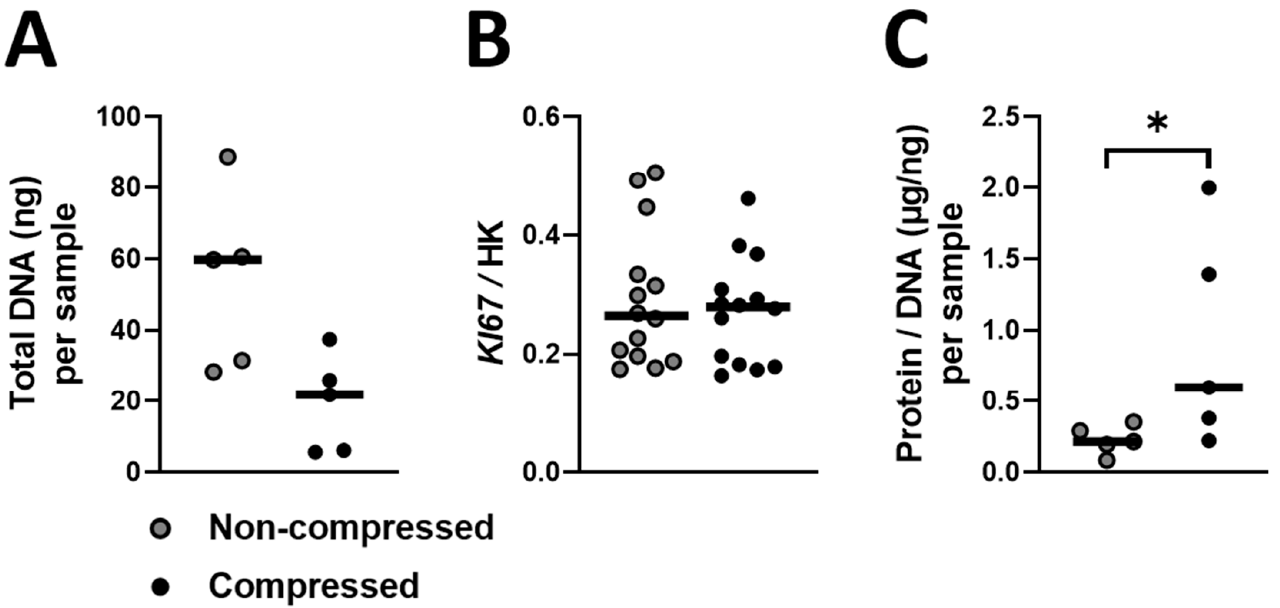
Figure 1. Effect of 2 kPa compression on DU145 Total DNA, proliferation and Protein/DNA . 5 separate cultures of DU145 cells were compressed with 2 kPa for 2 days. We then quantified ( A ) Total DNA using a CyQUANT Cell Proliferation Assay as a surrogate for cell number per sample (ng, n = 5), and ( B ) Total protein using a Pierce BCA Protein Assay Kit. Total protein per sample was divided through Total DNA per sample to obtain an impression of protein production per cell for each sample (µg/ng, n = 5). ( C ) In other experiments, a total of 20 separate cultures of DU145 cells were compressed with 2 kPa for 2 days and RNA was isolated. KI67 gene expression was deter- mined as an indication for cell proliferation using qPCR. KI67 gene expression was detectable and quantifiable in 14 out of 20 samples ( n = 14). ( A , B ) Analyzed with paired t -tests, ( C ) Analyzed with a paired t -test on log-transformed data. * p < 0.05.